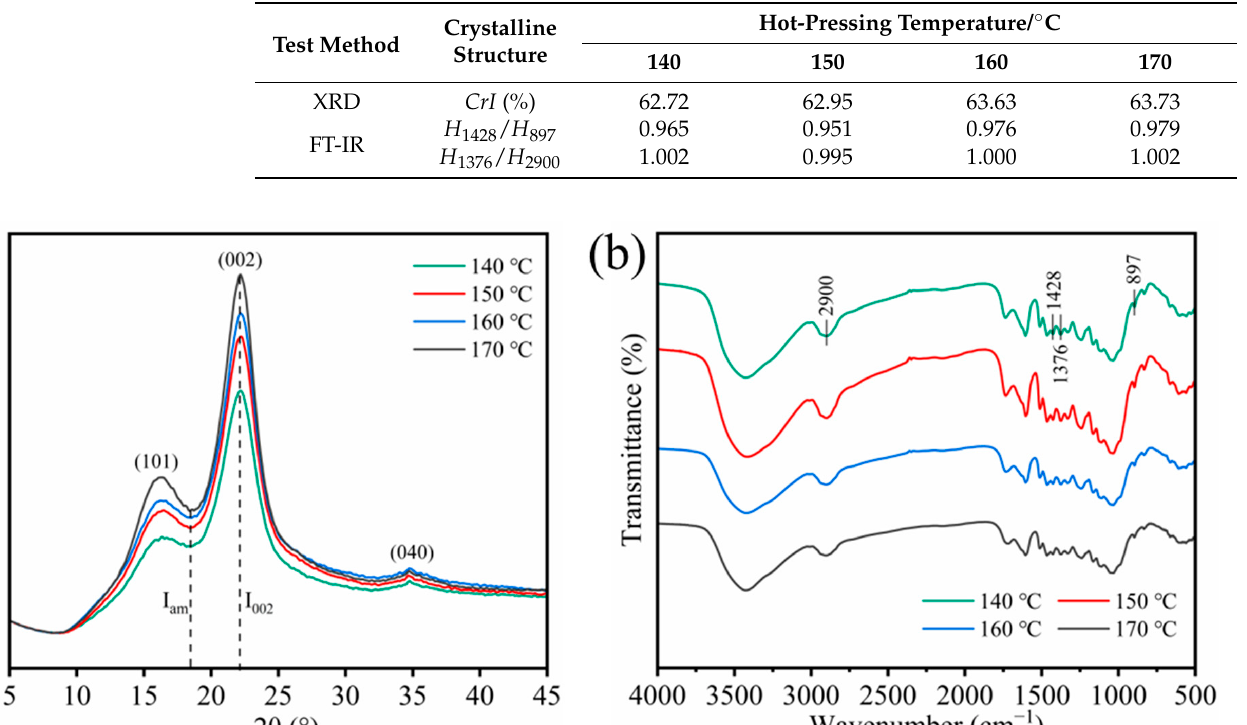
Table 4. The crystalline structure of cellulose in samples at hot-pressing temperatures of 140 °C, 150 °C, 160 °C, and 170 °C.